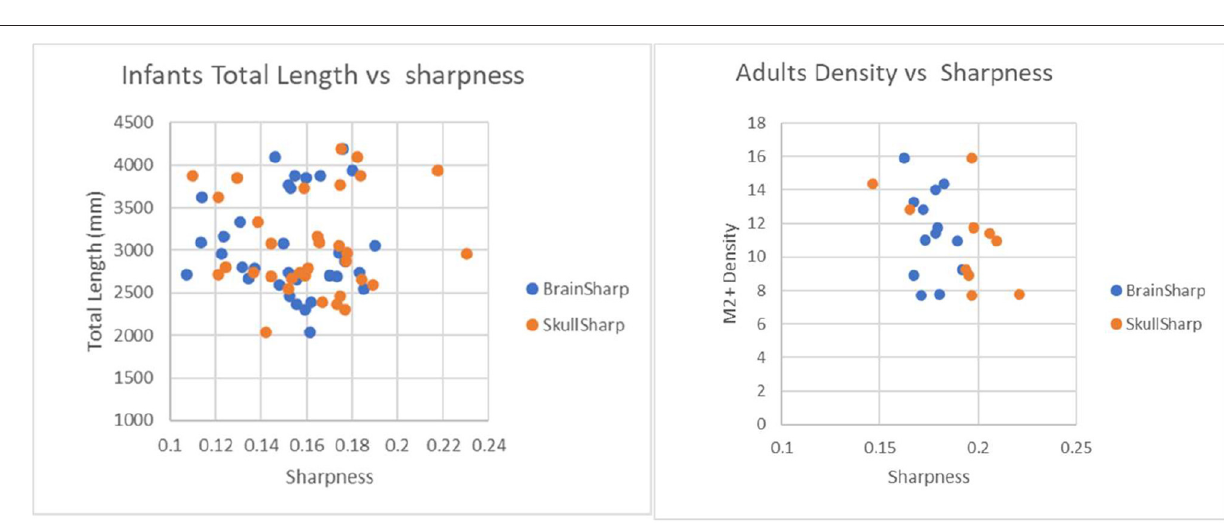
FIGURE 6 | Plot for density on infant (age group in months) and adults in left and right M2 + segments of MCA.